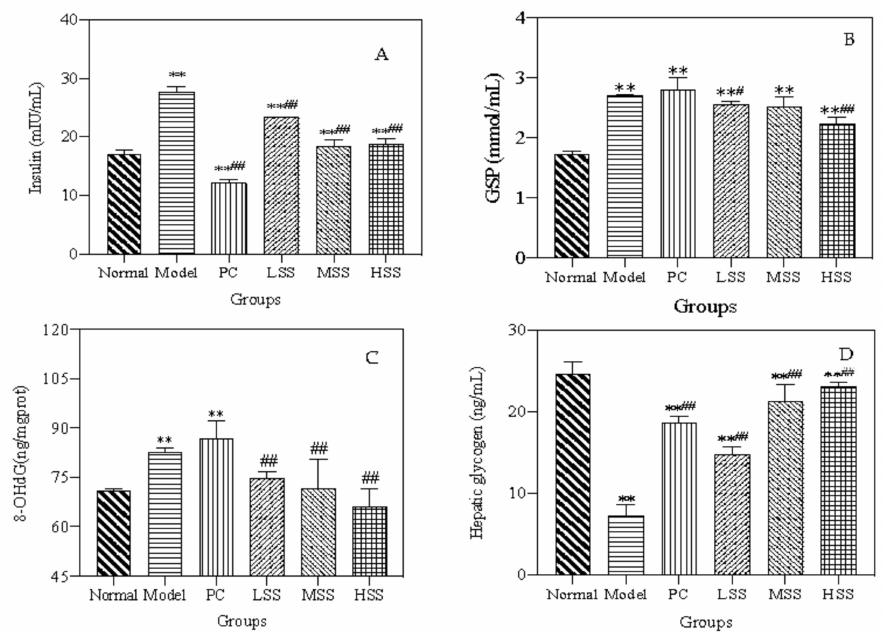
Figure 4. Effects of oral SS administration on physiological indexes of T2D rats. ( A ) Insulin; ( B ) GSP level; ( C ) 8-OHdG level; ( D ) Hepatic glycogen. Normal: normal group; Model: diabetic model group; PC: 0.5% metformin administration; LSS, MSS, and HSS: 1, 2.5, and 5% SS administration; n =